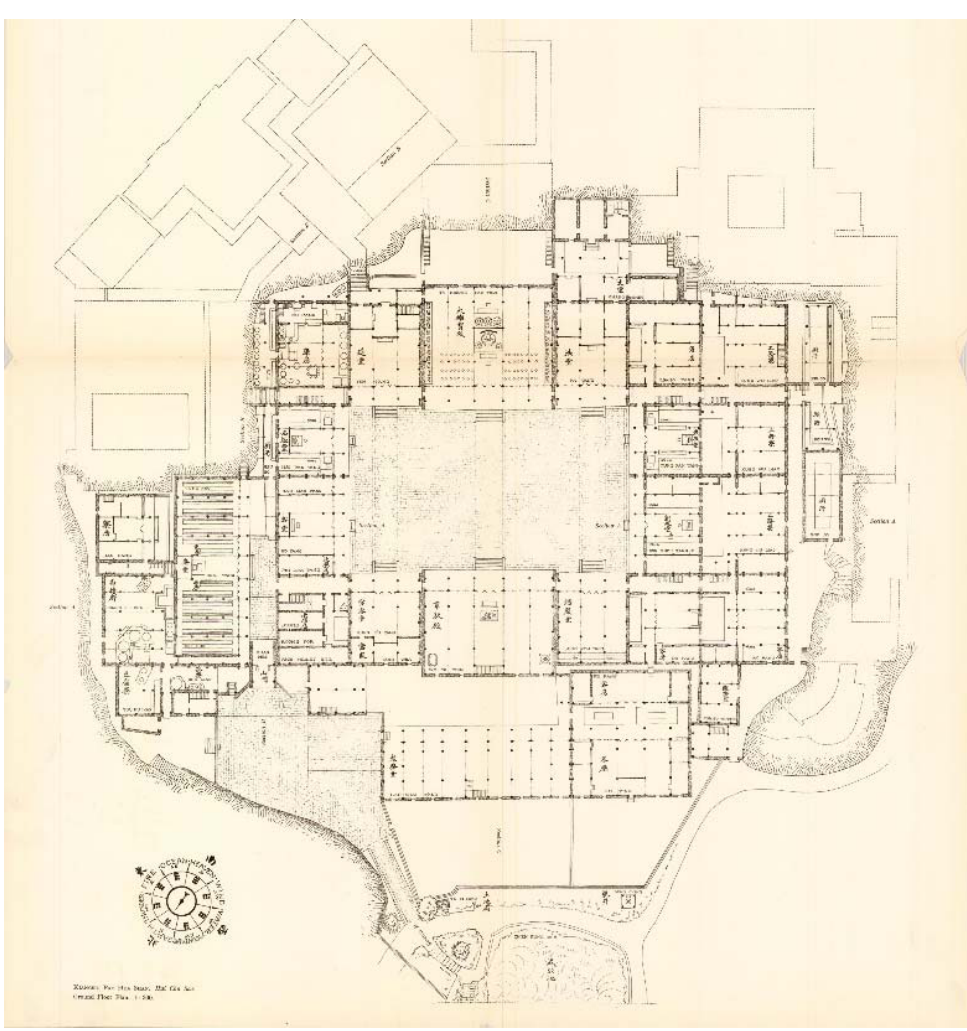
Figure 9. First floor plan of Longchang Monastery in 1930 (Prip ‐ Møller 1937, Pl. 1).